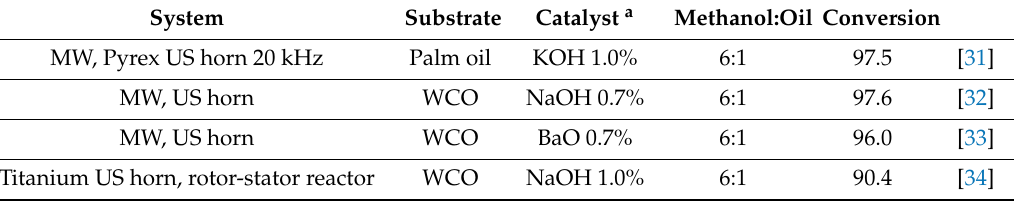
Table 3. Combined techniques for biodiesel preparation.